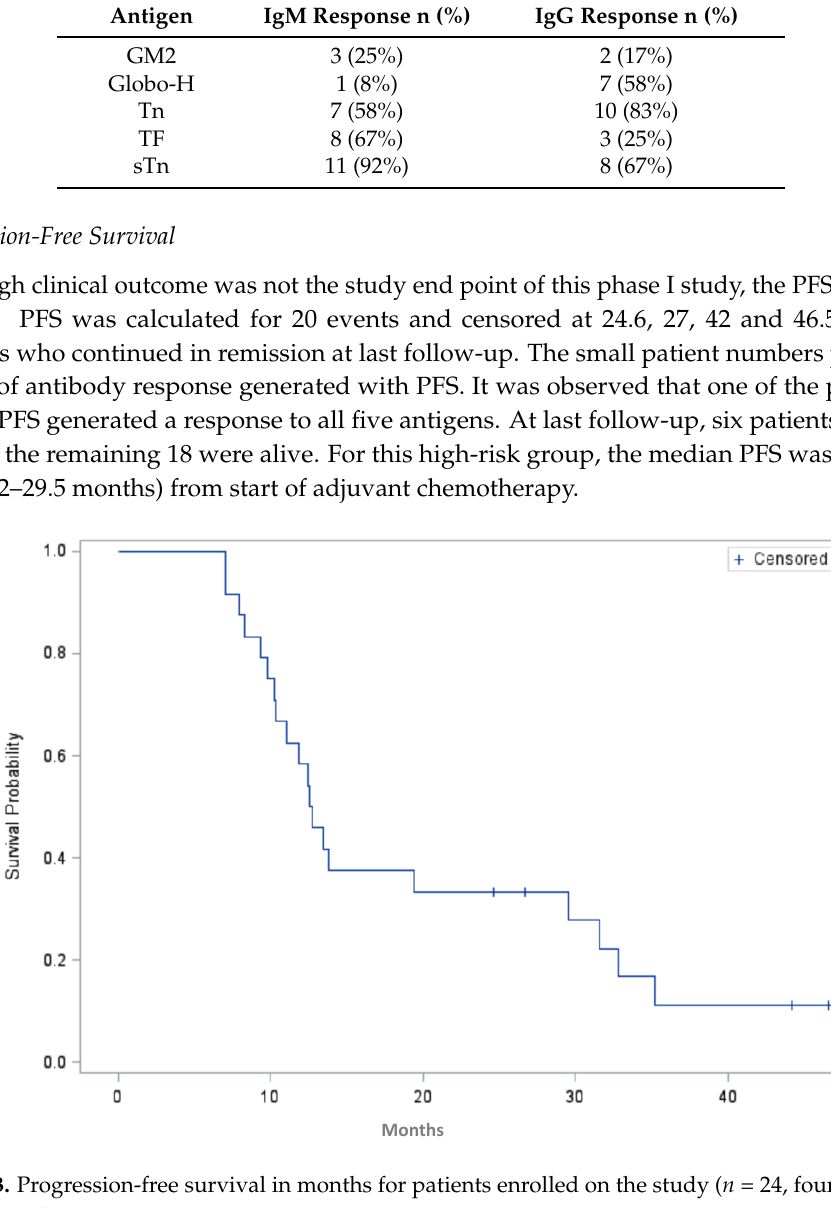
Table 3. Serologic IgM and IgG responses to antigens at the highest dose level tested ( n = 12).